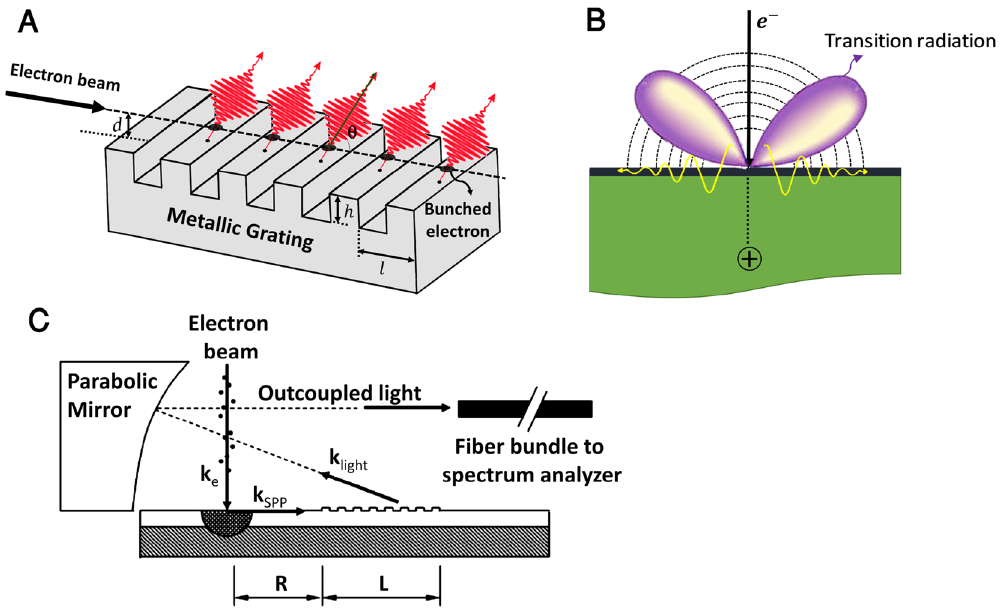
Figure1: Schematicsdiagramofdifferentmechanismsofradiationsfromelectronbeamsinteractingwithnanoscopicandmesoscopicmatter. (A)Smith-Purcellradiationasaresultofanelectrontravelingparalleltothesurfaceofametallicgrating.(B)Emittedtransitionradiationwhen the electron passes through the material and dielectric. (C) Experimental setup for excitation of surface plasmon polariton with wave vector k SPP by direct injection of a beam of free electrons of wave vector k e and their decoupling as a light by grating